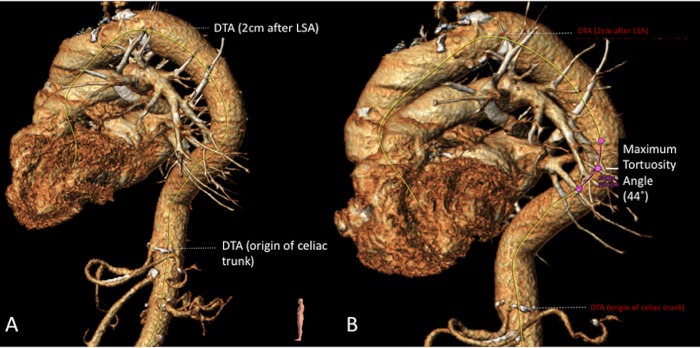
CT scan measurements performed in 3Mensio software.Two images of measurements in 3Mensio in the DTA; A: Center lumen line created for zone 4 (yellow line), with the start of the DTA 2 cm after the LSA up to the celiac trunk; B: Maximum tortuosity angle with two line elements that are defined by three control points over the centerline to measure the tortuosity in degrees.